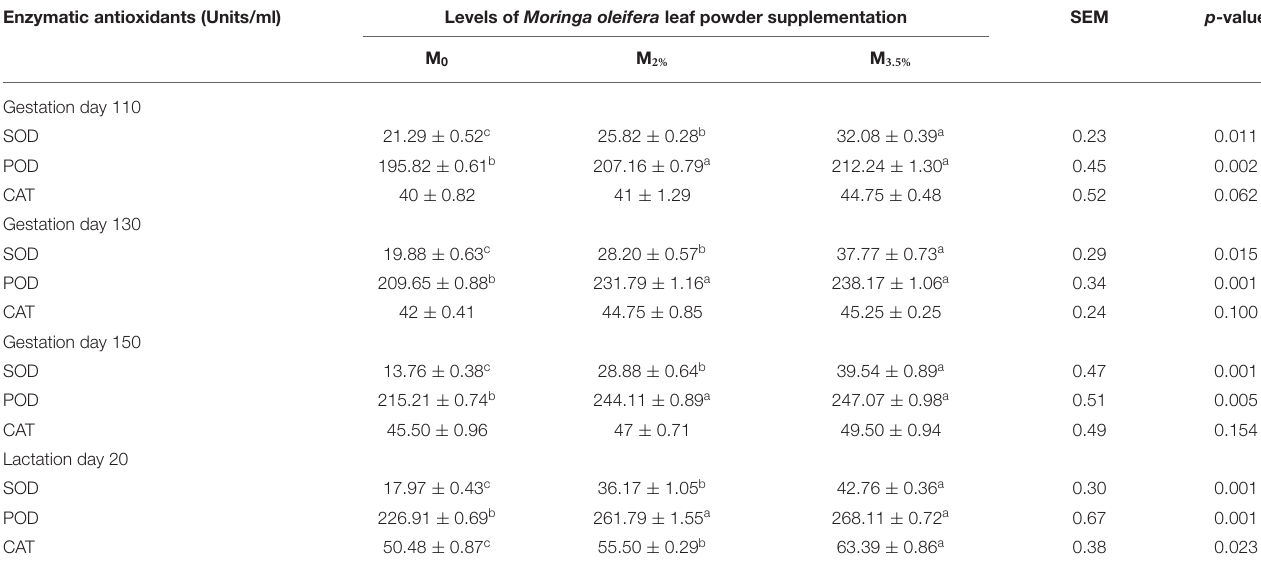
TABLE 5 | Plasma enzymatic antioxidant indices of Beetal goats. Enzymatic antioxidants (Units/ml)